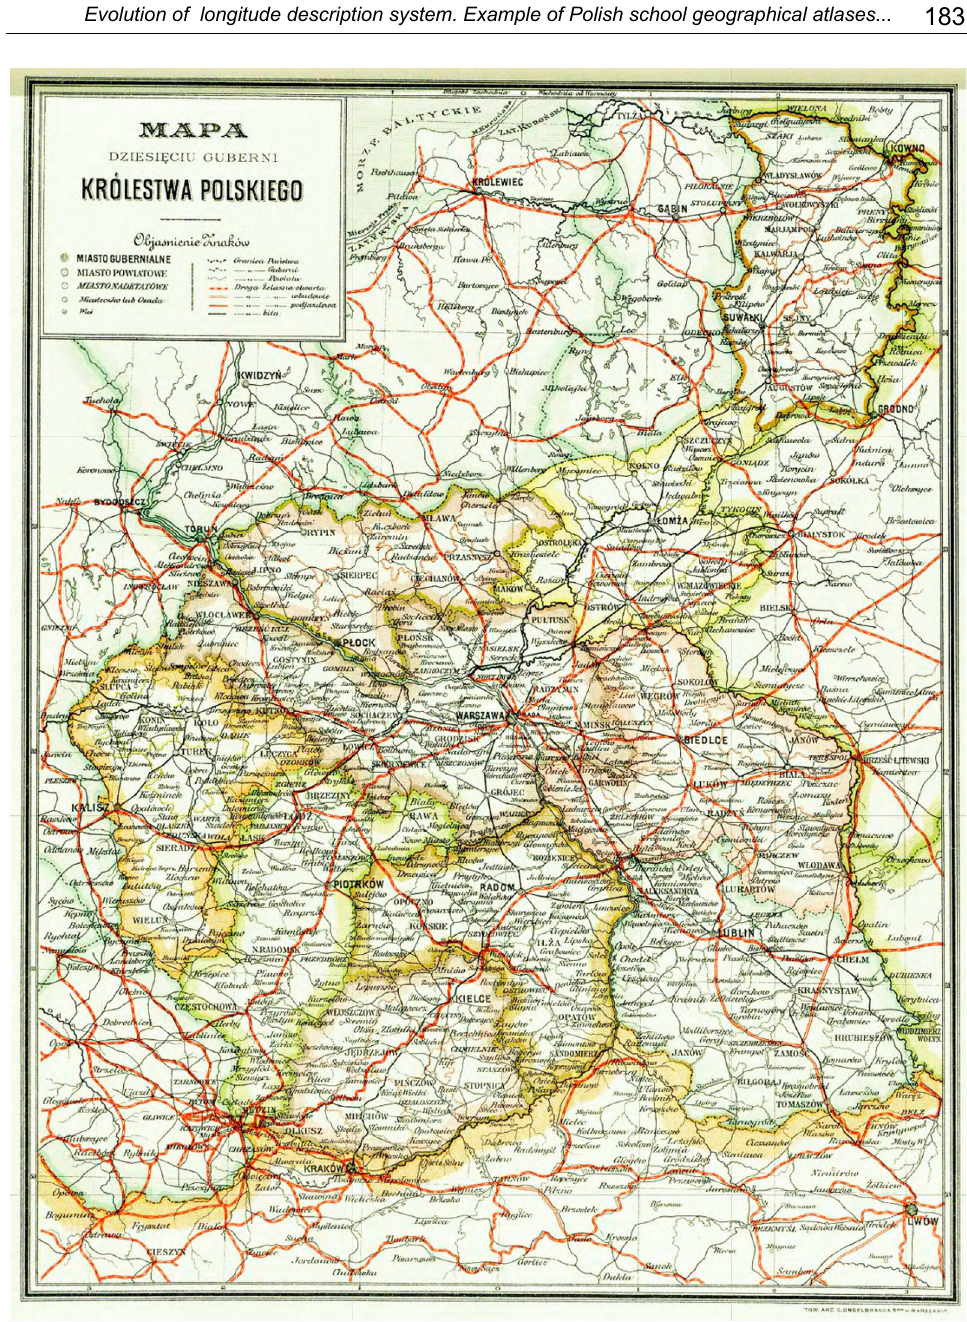
Fig. 4. The map of the Kingdom of Poland with the longitude indicated in relation to the Warsaw Meridian from the Podręczny atlas geograficzny (Geographical hand atlas) of the Orgelbrand Publishing House, about 1908 [20], table